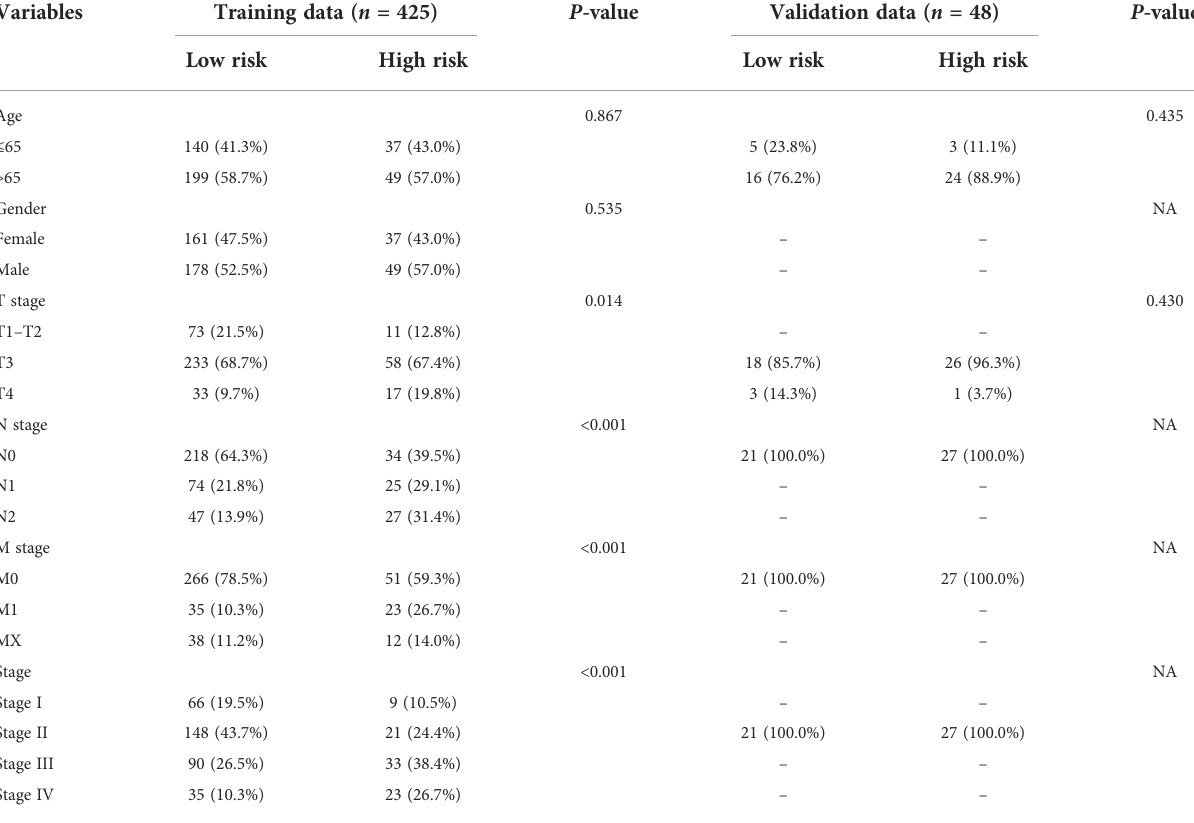
TABLE 1 Clinical characteristics of the colon patients between the high- and low-risk groups. Variables